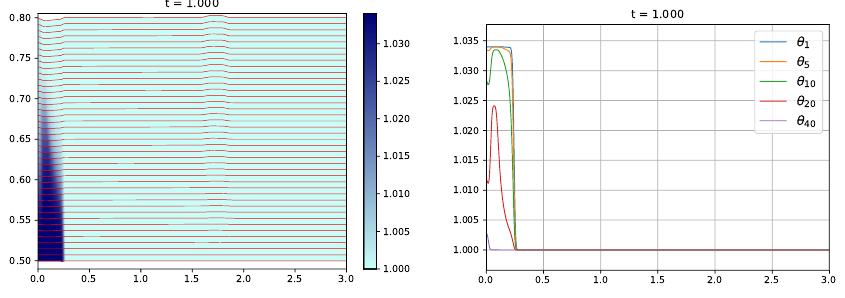
Figure 20. Evolution of the density driven current at t = 1 s.